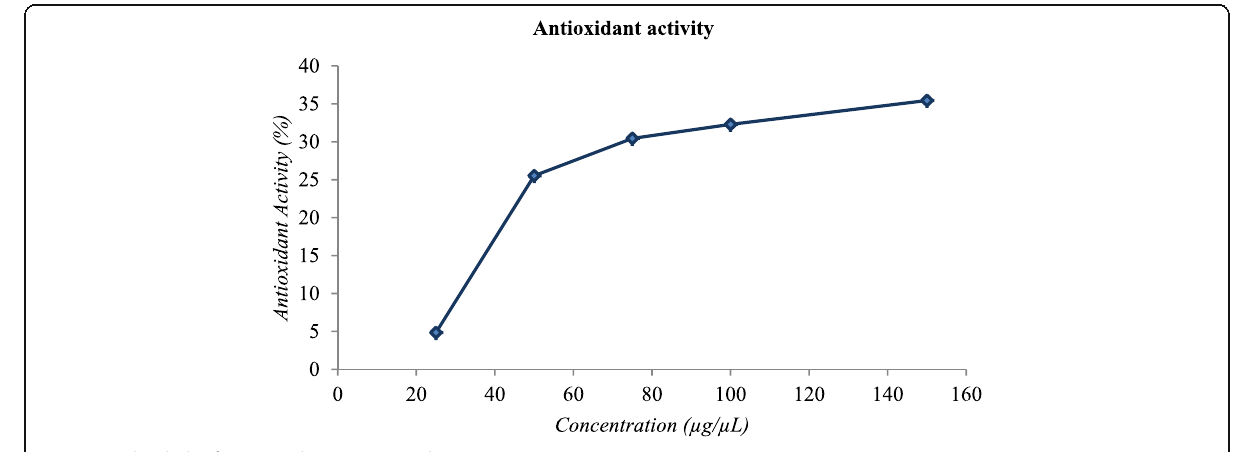
Fig. 2 Graphical plot for antioxidant activity